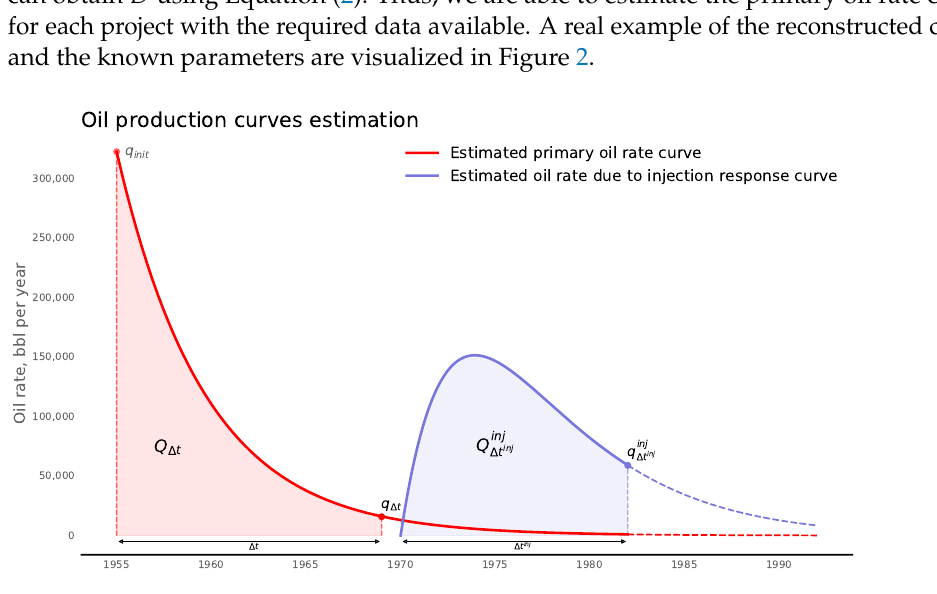
Figure 2. Plot demonstrates example of the reconstructed production oil curves for waterflooding project. Red line—reconstructed primary rate oil curve. Blue line—reconstructed oil rate due to injection response. The parameters available in the database are shown in bold